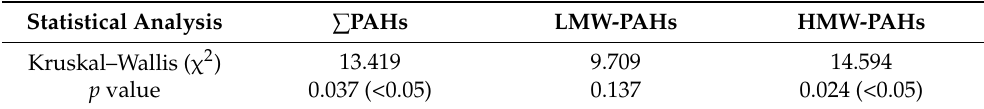
Table 4. Statistical data results of Kruskal–Wallis test, PAHs in soil from different regions of pro- cess